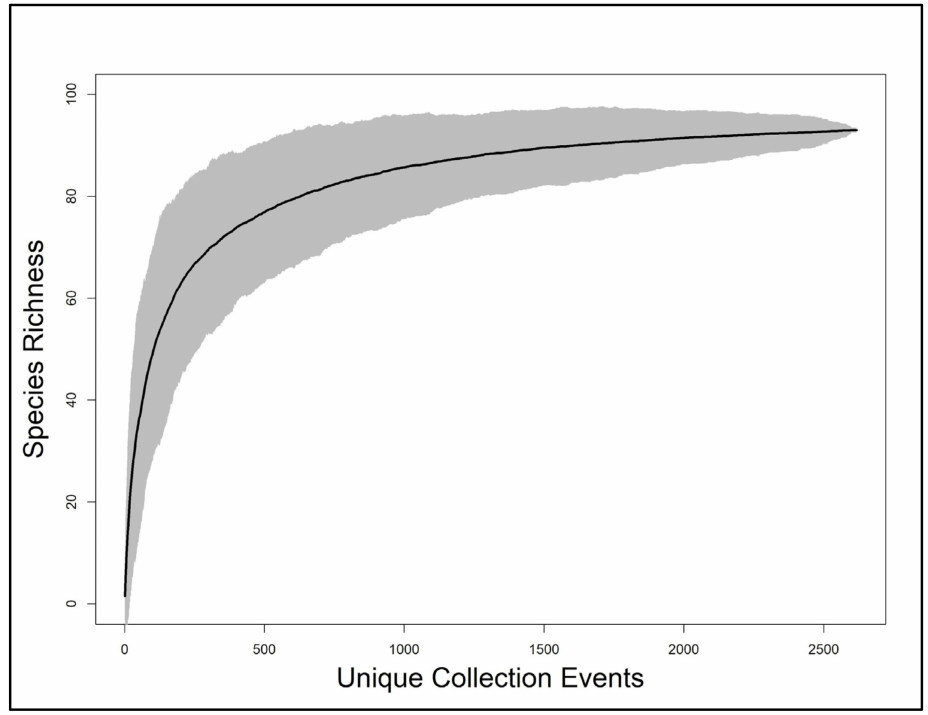
Figure 5. Species accumulation curve with 95% confidence interval (gray shade) for Indiana Ple- coptera using unique collection events as replicates. Terminal estimation was 95 ± 5